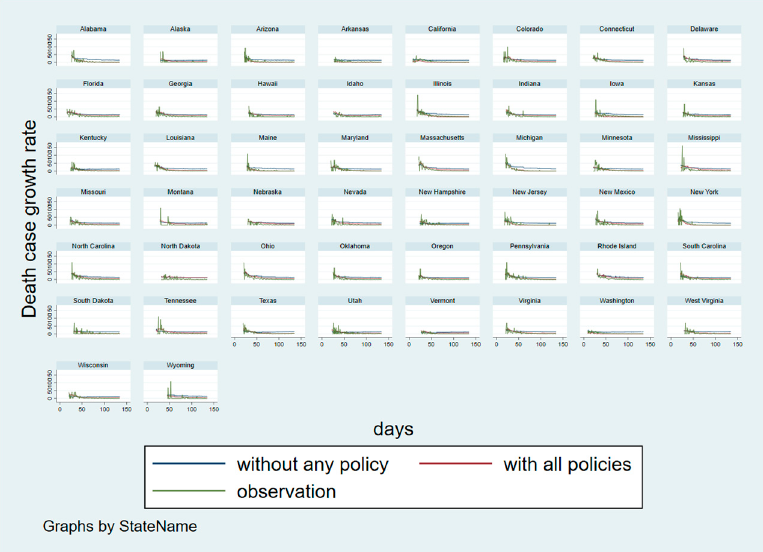
Figure 5. Counterfactual analysis: state-specific time trends for the death case growth rate with and without social distancing